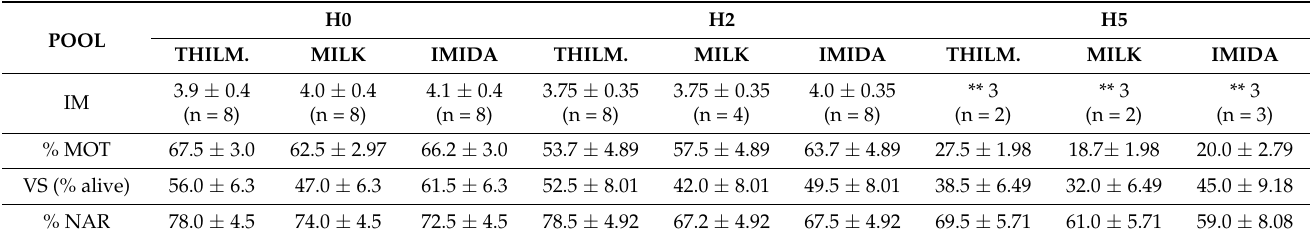
Table 9. Average semen quality parameters by subjective microscopic evaluation for the pool of males in endurance test, according to